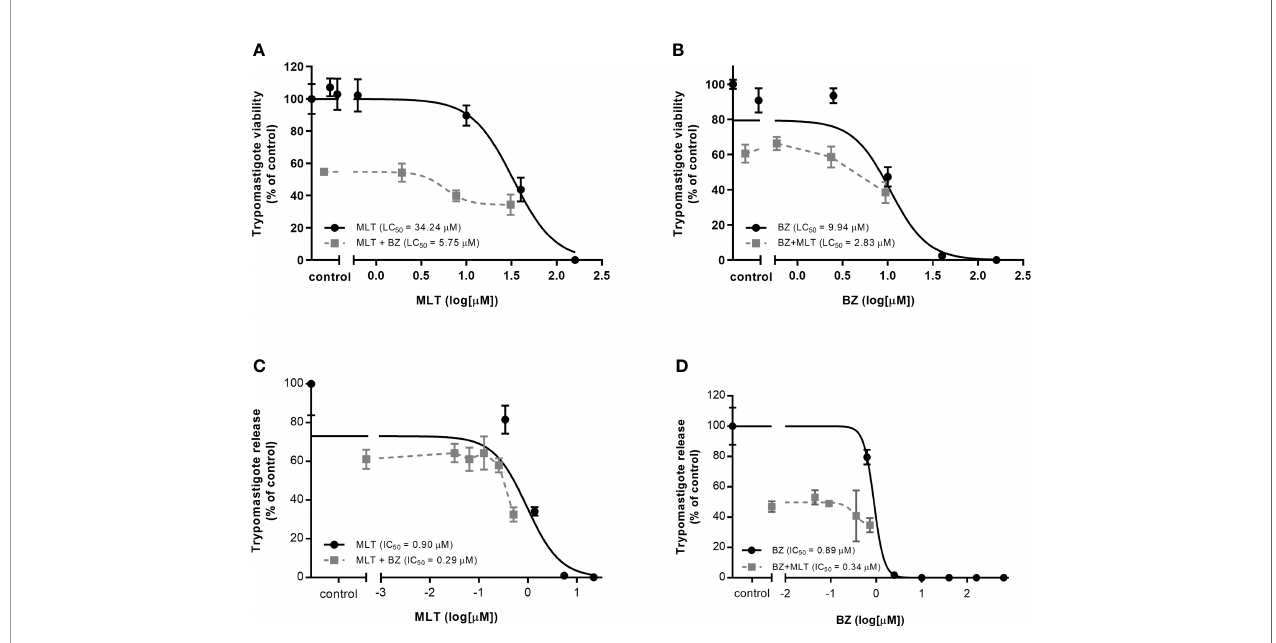
FIGURE 1 | In vitro activity of miltefosine (MLT) and benznidazole (BZ) combination on (A-B) trypomastigotes and intracellular amastigote development (C-D) of Trypanosoma cruzi (VD strain). (A) LC 50 value from BZ combined with variable concentrations of MLT. (B) LC 50 value from MLT combined with variable concentrations of BZ. (C) IC 50 value from BZ combined with variable concentrations of MLT. (D) IC 50 value from MLT combined with variable concentrations of BZ. Values are expressed in µM and reported as the mean concentration and the 95% con fi dence interval (IC95%).